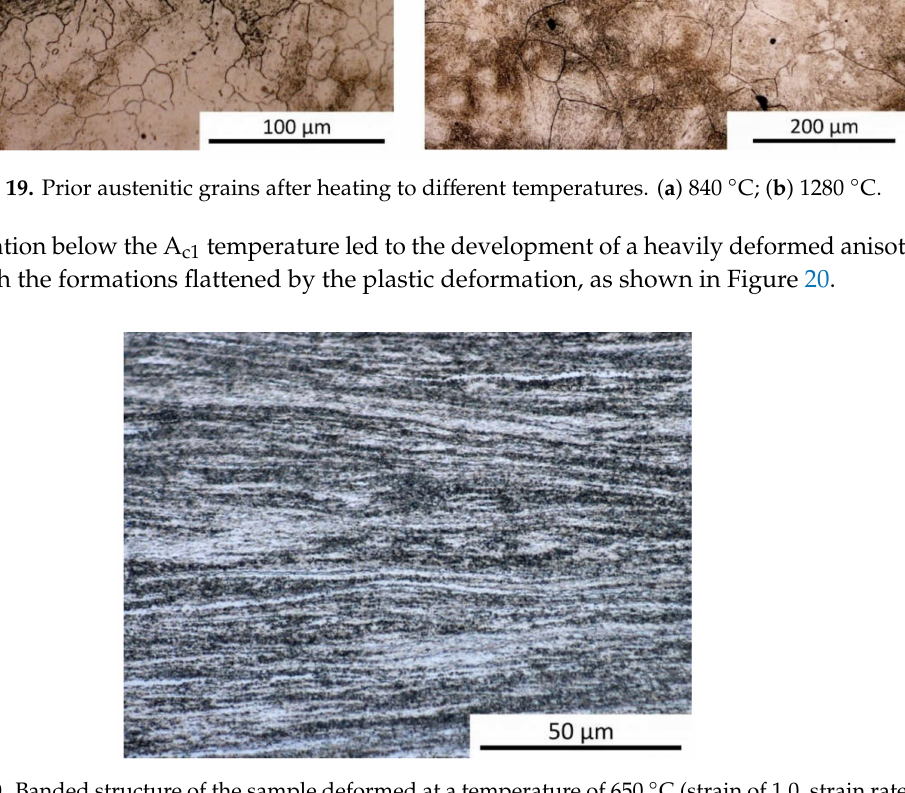
Figure 20. Banded structure of the sample deformed at a temperature of 650 ◦ C (strain of 1.0, strain rate of 0.02 s − 1 ; the compression was set in the vertical direction of the image)—light